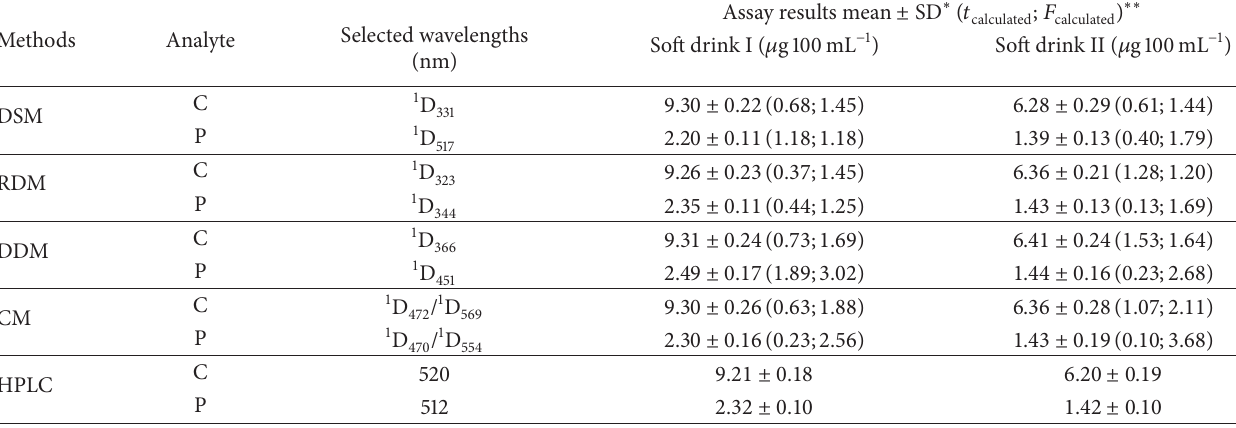
Table 4: Assay results for the determination of Carmoisine and Ponceau 4R in soft drinks using the proposed methods and the reference HPLC method (NMKL